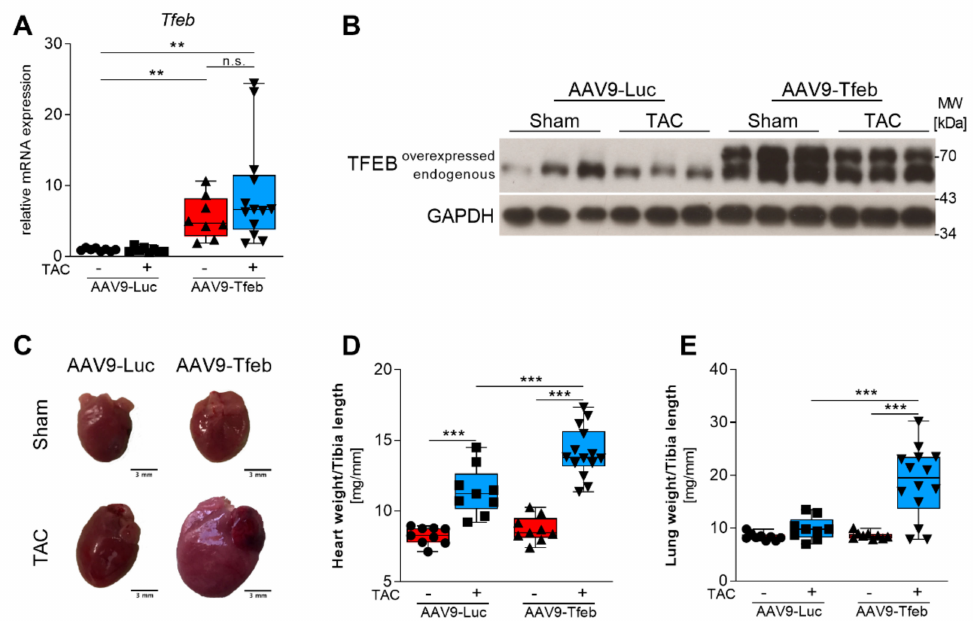
Figure 1. Cardiomyocyte-specific overexpression of TFEB leads to heart failure in response to 28 days of pressure overload. ( A ) qRT-PCR results of Tfeb mRNA expression normalized to geometric mean of Ipo8, Mrpl13 and Pgk1 and shown as mean ± SEM. ** p < 0.01; n.s. not significant. ( B ) Western blot analysis of protein lysates from hearts to analyse TFEB protein levels. Overex- pressed and endogenous TFEB are indicated. Glyceraldehyde-3-phosphate dehydrogenase (GAPDH) protein content was used as loading control. ( C ) Gross morphology of representative hearts of sham and TAC treated AAV9-Luc and AAV9-Tfeb mice are shown. ( D ) Heart weight/tibia length (HW/TL) and ( E ) Lung weight/tibia length (LW/TL) ratios of AAV9-Luc and AAV9-Tfeb mice 28 days after sham and TAC surgery are shown. Box plots show median and interquartile range (IQR) ± minimum to maximum values. *** p <